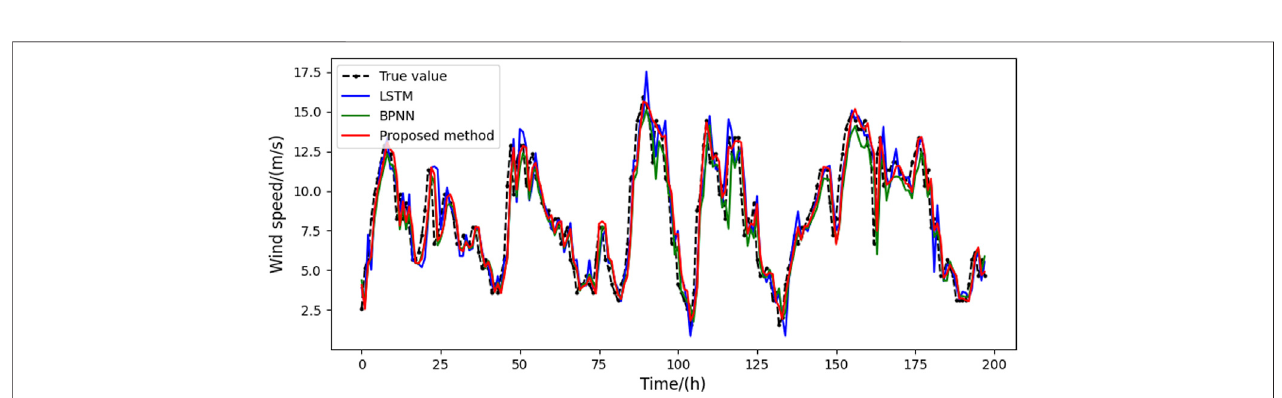
FIGURE 7 | Prediction results of three different methods in